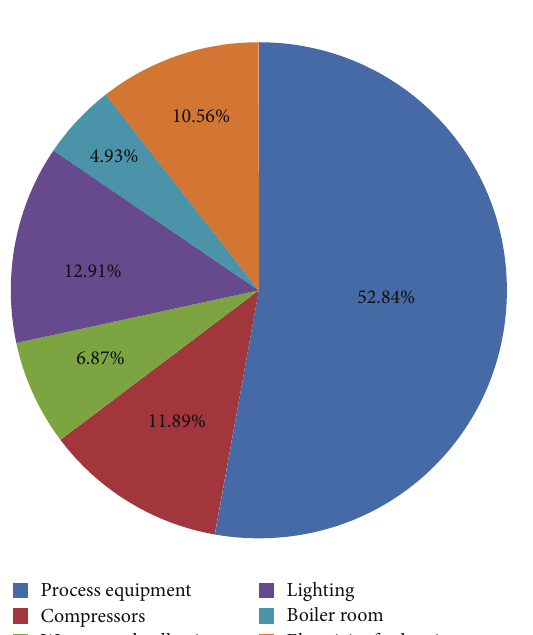
Figure 2: Distribution of electricity consumption in a wood furni- ture industry